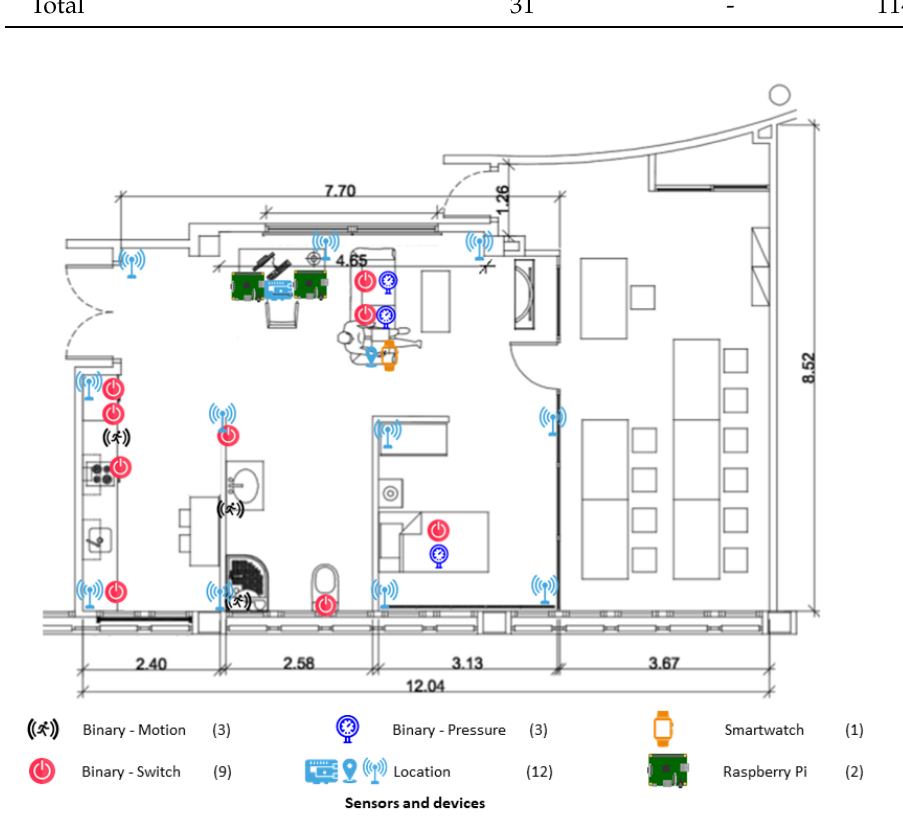
Figure 14. Deployment of the different sensors in the Smart